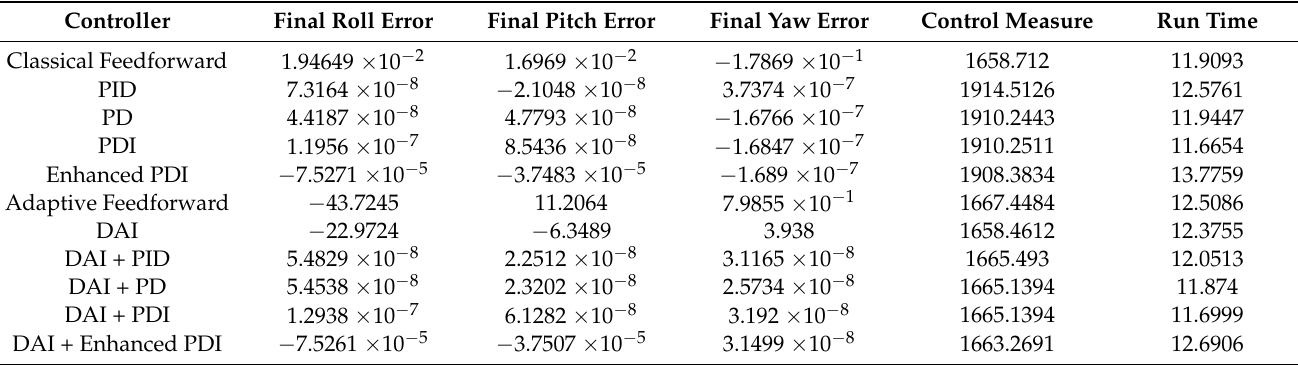
Table 5. Controller analysis for Pontryagin generated trajectory without principal to body frame